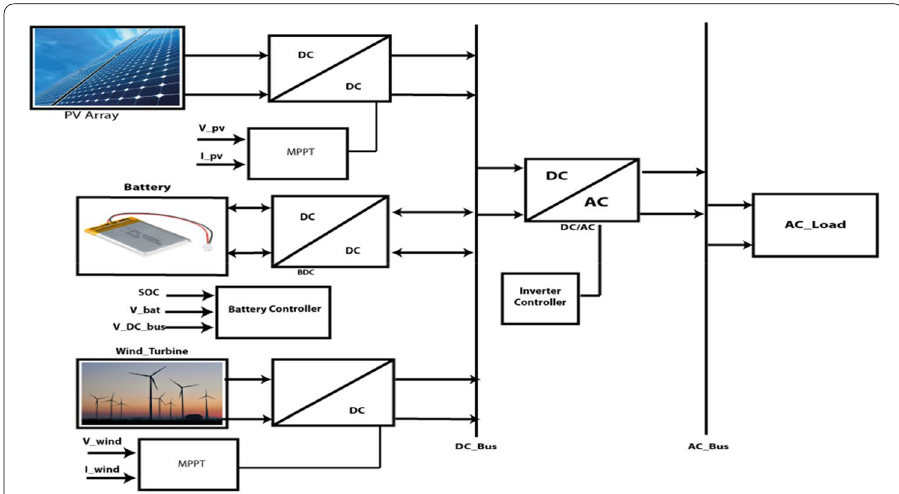
Fig. 10 Proposed energy management for the hybrid